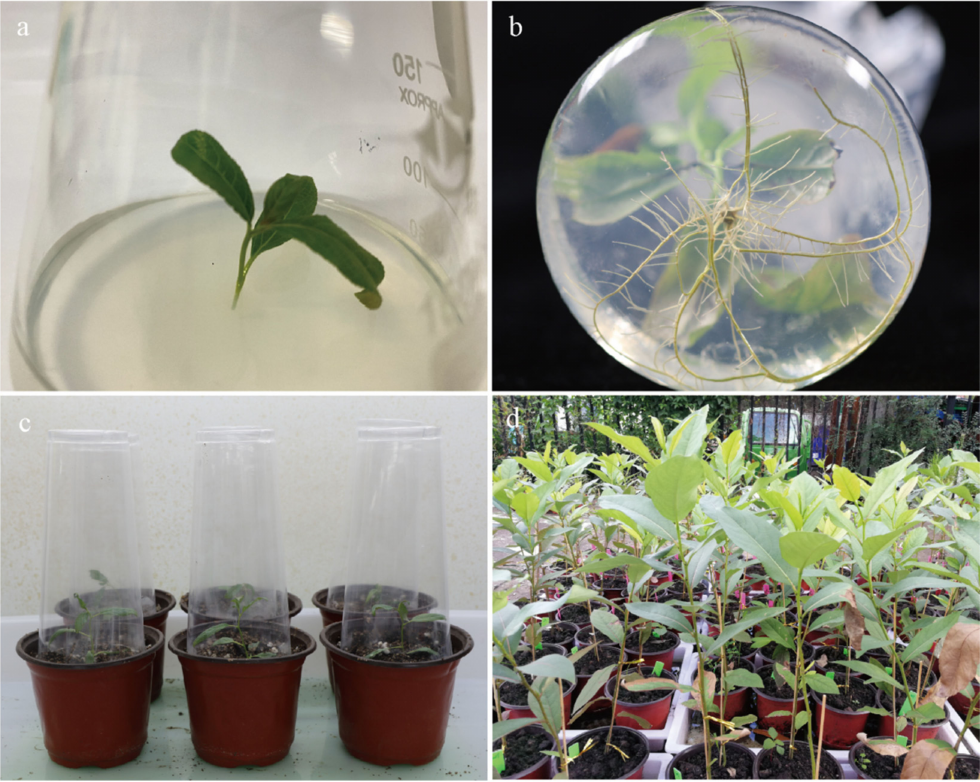
Figure 2. Rooting and acclimatization: ( a , b ) Rooting on PGR-free half-strength MS medium. ( c ) Hardening of in vitro-raised P. ussuriensis. ( d ) P. ussuriensis seedlings grown outdoors under natural